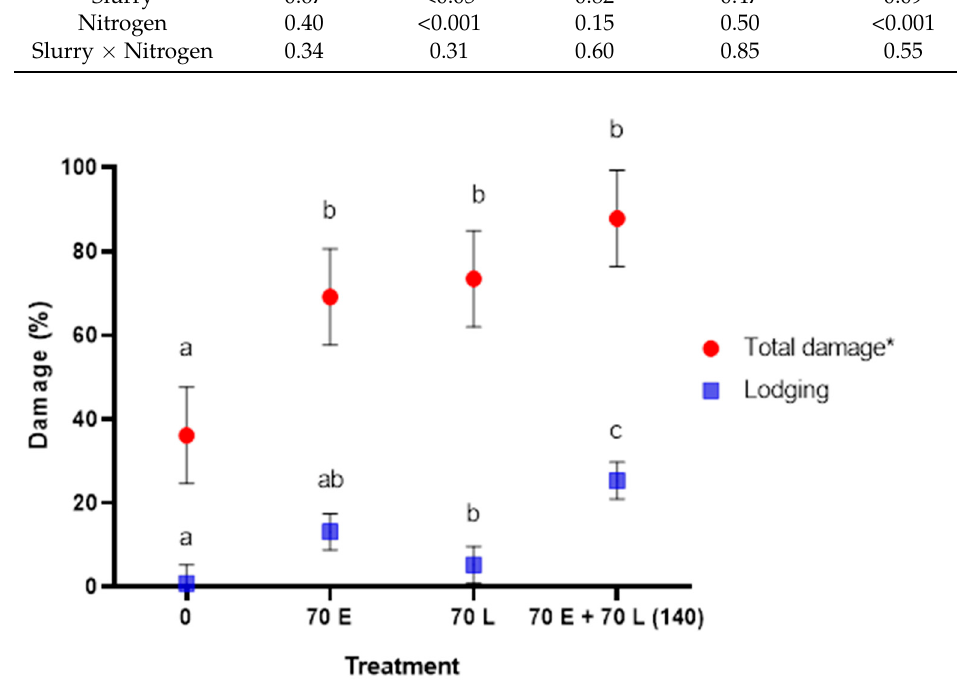
Figure 5. 2016/2017 straw damage assessed pre-harvest. * Total damage = sum of leaning, lodging, brackling and neckling. Error bars represent standard error of the mean (SEM). Means which share different letters are significantly ( p < 0.05) different to each other determined by Fishers’s Protected LSD (0.05).